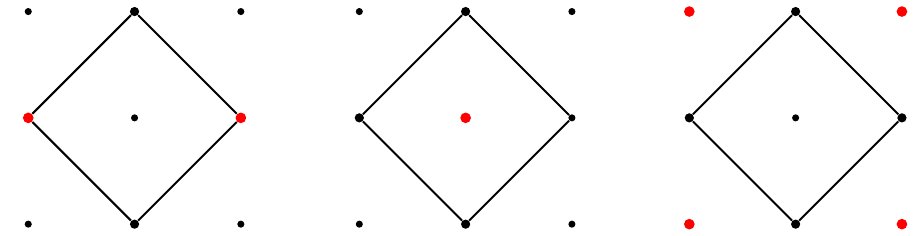
. The right (cid:12)gure shows the toric involution 2